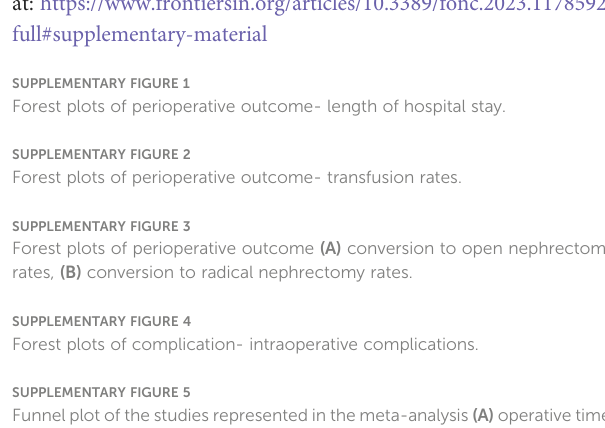
SUPPLEMENTARY FIGURE 1 Forest plots of perioperative outcome- length of hospital stay. SUPPLEMENTARY FIGURE 2 Forest plots of perioperative outcome- transfusion rates. SUPPLEMENTARY FIGURE 3 Forest plots of perioperative outcome (A) conversion to open nephrectomy rates, (B) conversion to radical nephrectomy rates. SUPPLEMENTARY FIGURE 4 Forest plots of complication- intraoperative complications. SUPPLEMENTARY FIGURE 5 Funnelplot of the studies represented in the meta-analysis (A) operative time, (B) warm ischemia time, (C) blood loss, (D) major